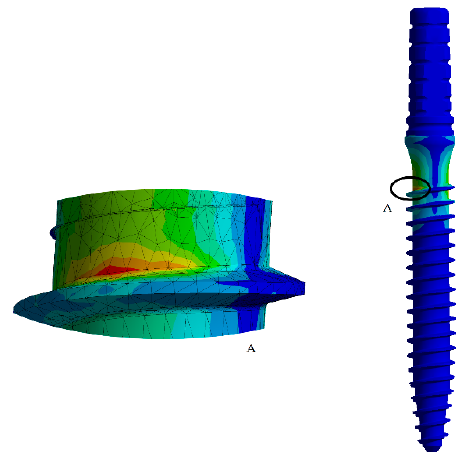
Figure 4. Stress distribution along the implant.